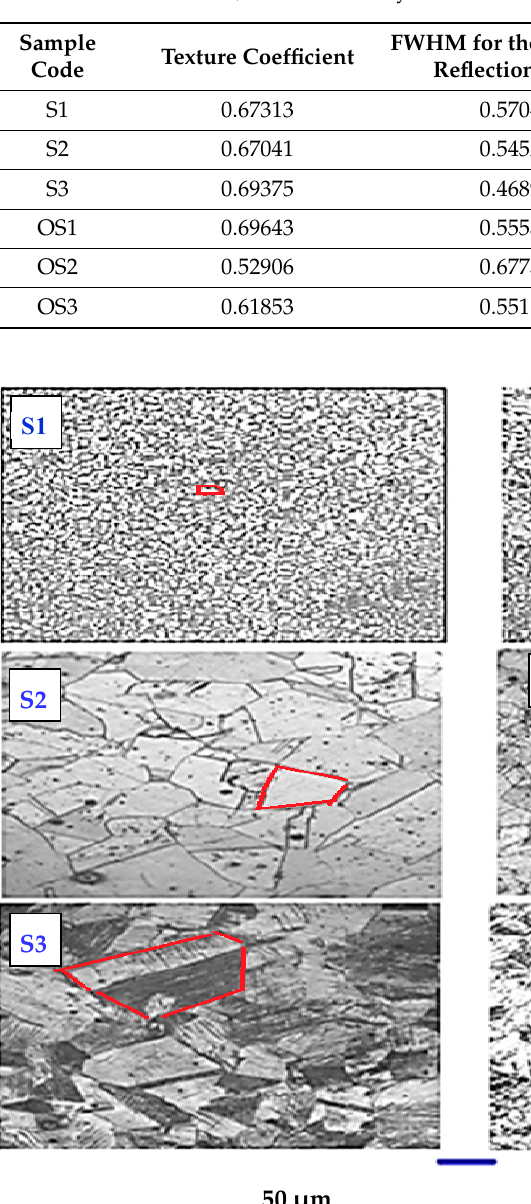
Table 2. Texture coefficient, FWHM and Crystallite size obtained by XRD analysis.